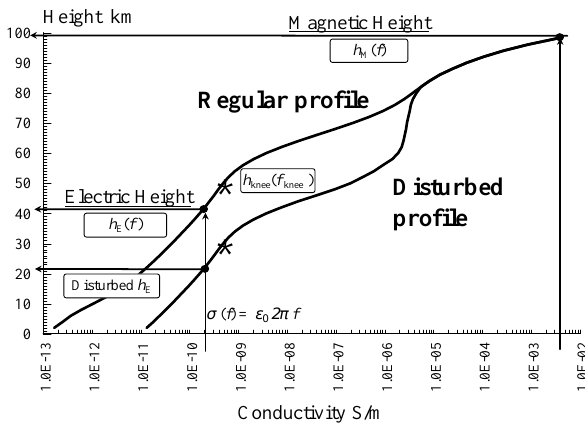
Fig. 1. Quiet and disturbed conductivity profiles with a scheme of how the propagation parameters are